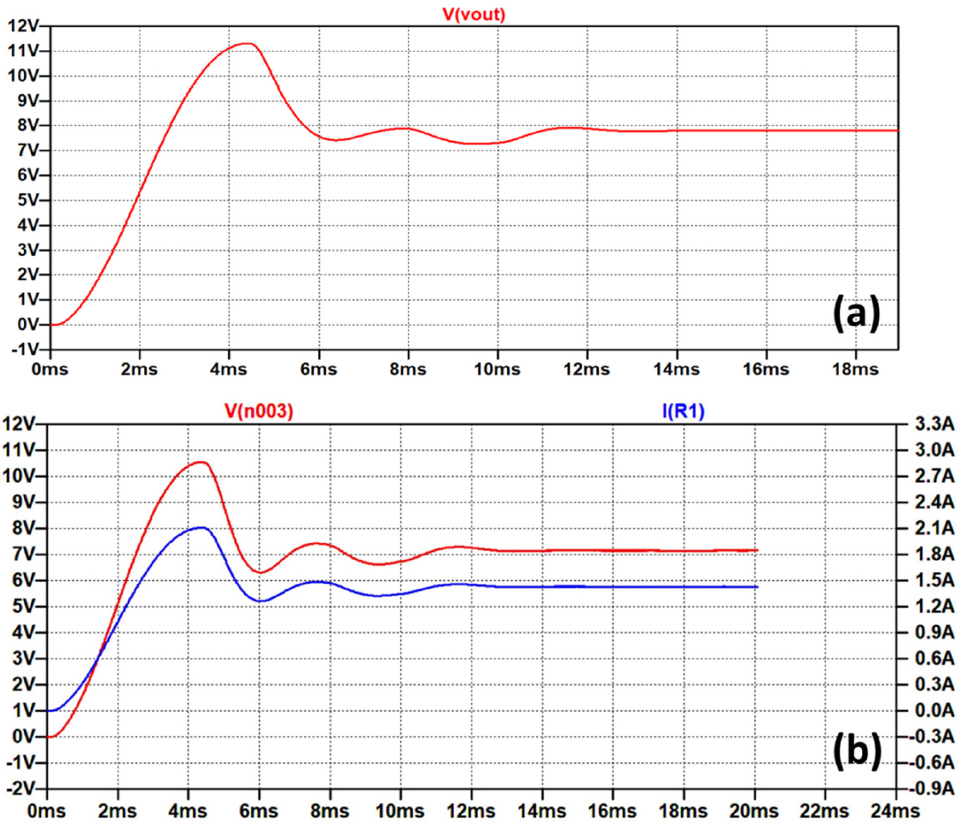
Figure 11. ( a ) The output-voltage response with resistive load; ( b ) the output current and voltage response of the circuit with resistive load.